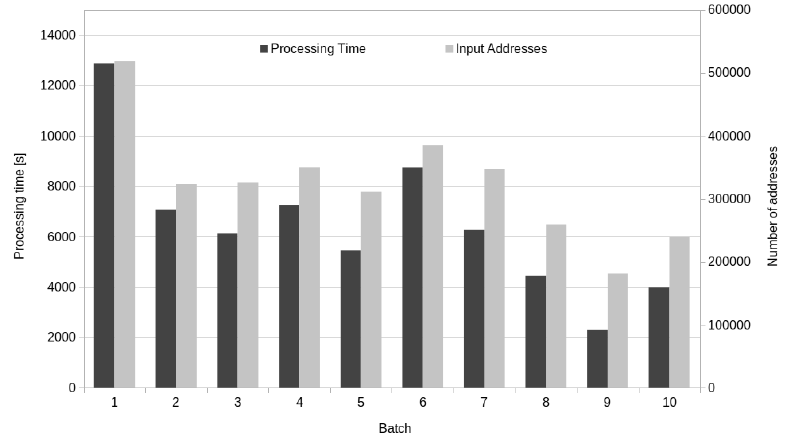
Figure 5. ETL processing time for the first 10 batches (left axis) and the corresponding number of addresses-transaction rows in the table inputSection (right